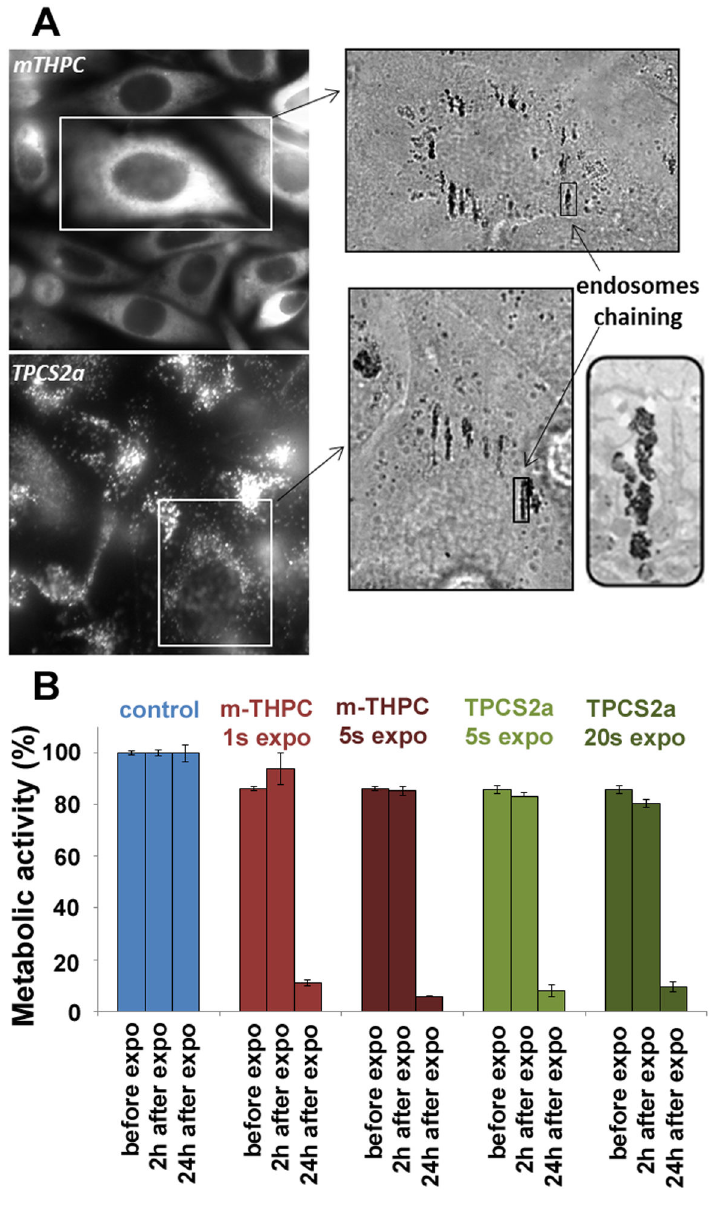
Figure 1. Intracellular localization of the photosensitizers and the magnetic nanoparticles and metabolic activity. (A) Co- internalization, in PC3 tumor cells, of photosensitizer molecules (mTHPC and TPCS2a) and magnetic nanoparticles. mTHPC localizes in the cytoplasm while TPCS2a is found in vesicular structures. The magnetic nanoparticles are concentrated in late endosomes and lysosomes, and align in the direction of the applied magnetic field, as shown by electron microscopy (inset). (B) Metabolic activity was not modified 2 hours after exposure, regardless of the conditions. The subsequent steps therefore involved viable cells. However, a noteworthy cytotoxic effect was detected the following day, with more than a 80% fall in cellular activity. The error bars represent the standard error of the mean